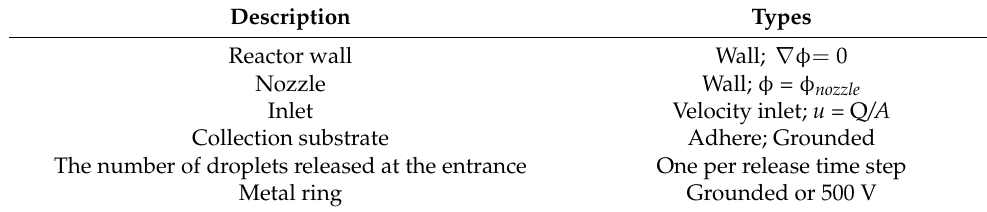
Table 2. Boundary conditions.